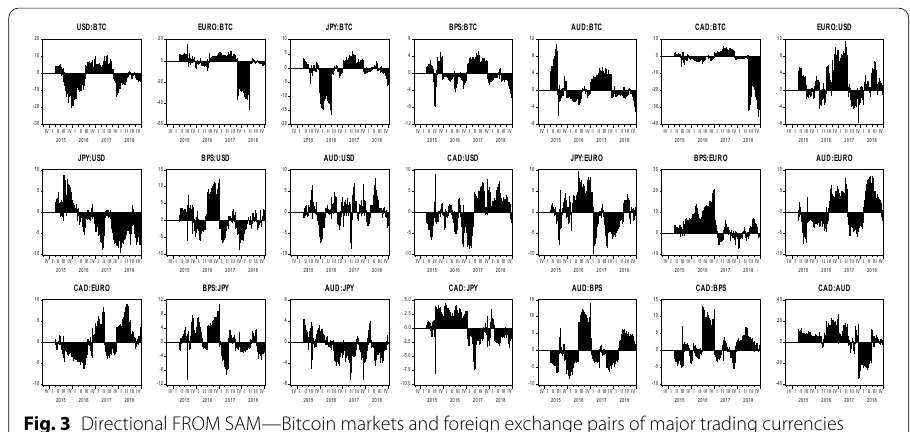
Fig. 3 Directional FROM SAM—Bitcoin markets and foreign exchange pairs of major trading currencies SAM H 2 N , i ←• The Y-axis depicts the volatility spillover values and the X-axis depicts the time period